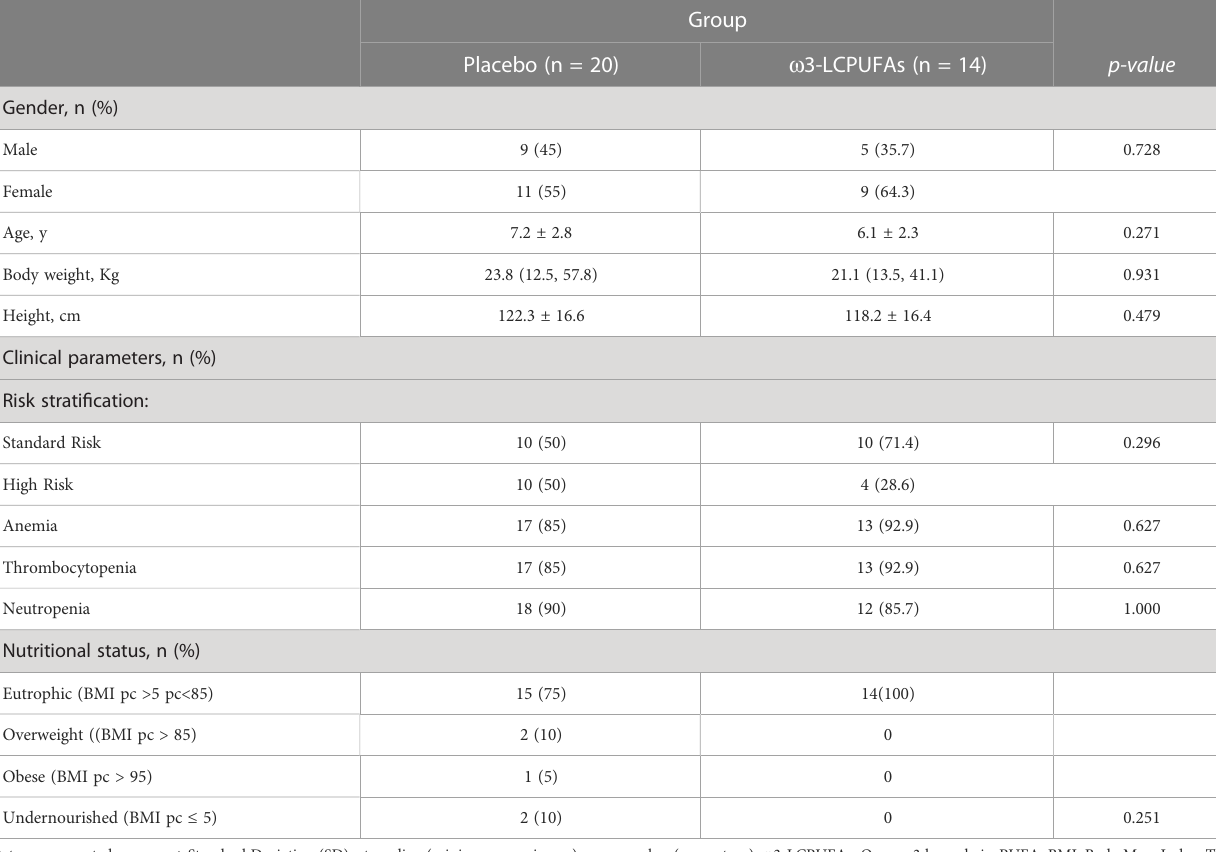
TABLE 1 Demographic, clinical, and baseline markers characteristics of children with